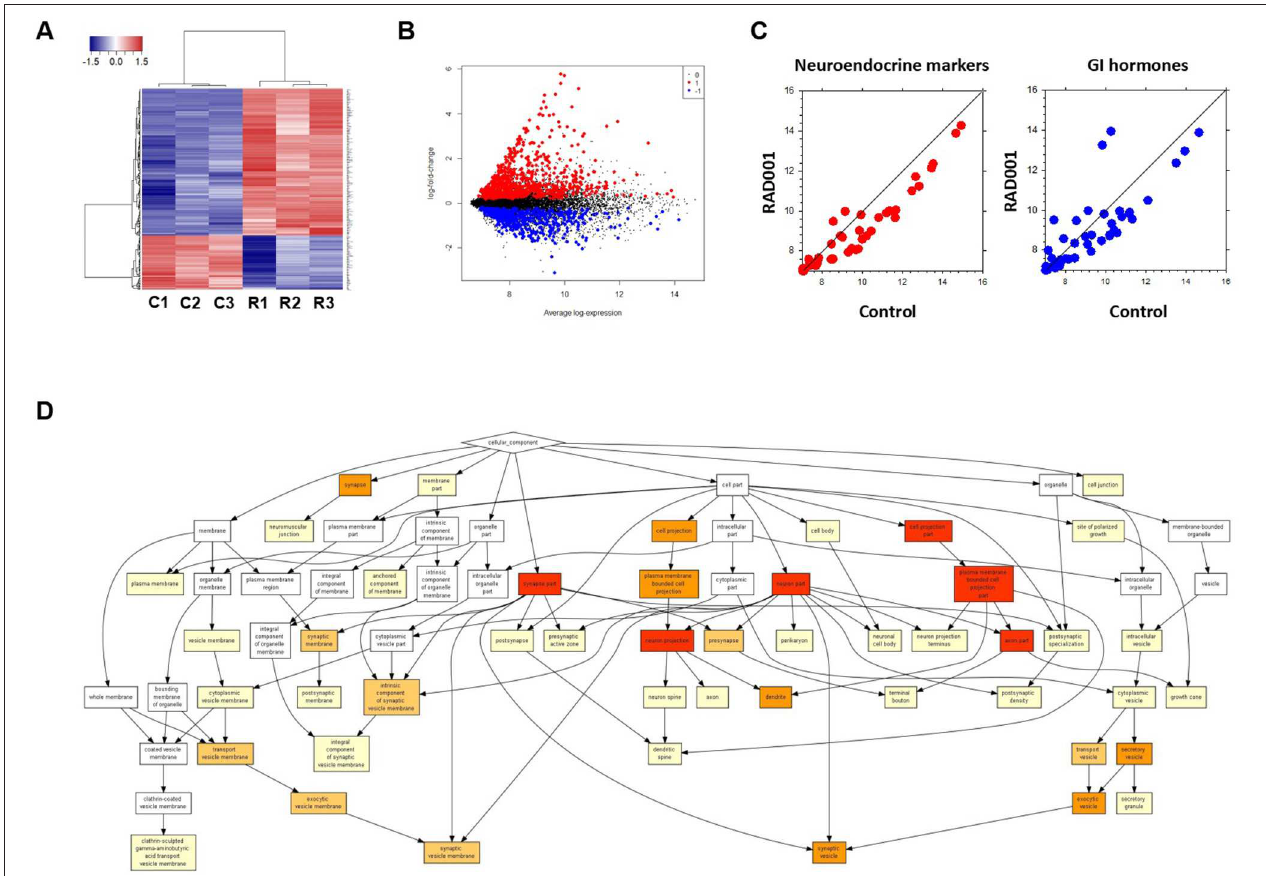
FIGURE 7 | Microarray analysis on tumor tissue samples from mice treated with RAD001 or placebo. (A) Transcriptome analysis in the tumor tissue samples by cDNA-array. Three samples from each group were included. C, control mouse treated with placebo; R, mice treated with 10 mg/kg RAD001. Gene expression was analyzed by cluster 3.0 and TreeView. (B) From the whole array, 1,344 genes show differential expression between control group and RAD001 treated group ( p < 0.05: RAD001 treated group vs. control group). Red: up-regulated for more than 2 folds; blue: down-regulated for more than 2 folds; black: fold change between − 2 and 2. (C) A down regulation of genes specific for neuroendocrine tumors and gastrointestinal hormones was observed in mice treated with RAD001 comparing to control mice. Data are expressed as exponent only (log 2 ). A position left from the diagonal indicates an increase, on the right an inhibition after RAD001 treatment. (D) GO analysis showed an enrichment of neuroendocrine related genes in the term of Cellular Component